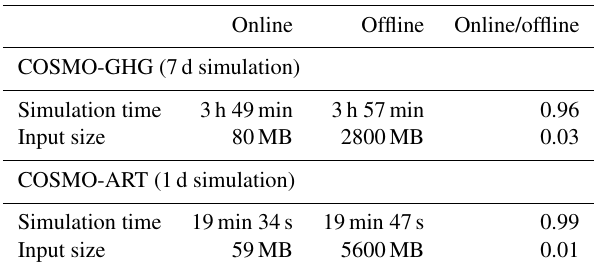
Table 5. Simulation time and input data size for online and offline COSMO-GHG and COSMO-ART test